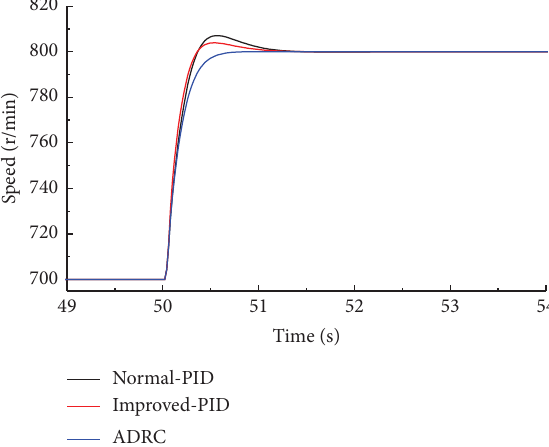
3 . (a) Speed diferential signal. (b) Engine status parameter Z 3 .